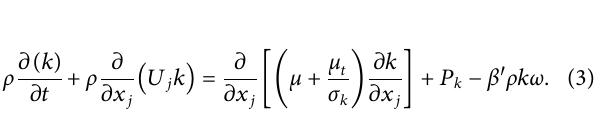
Figure 1 . Its main design parameters are listed in Table 1 below.